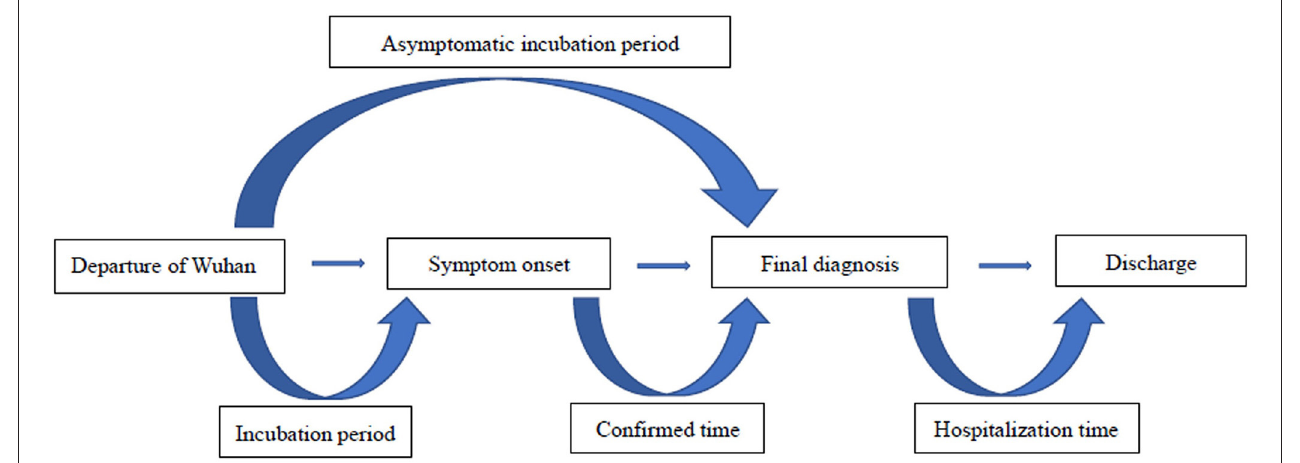
FIGURE 1 | Definitions of the main endpoints of this study.